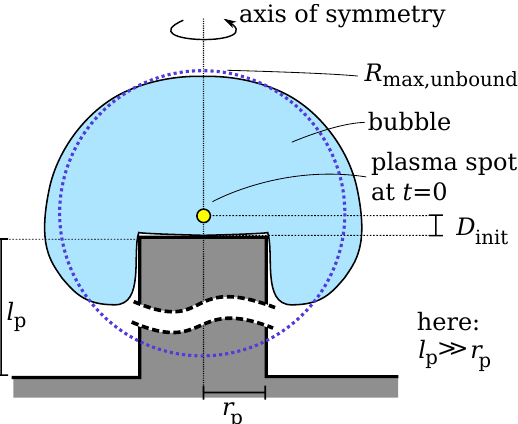
Figure 1. Sketch of the parameters for classification of bubbles close to a solid cylinder. The bubble is initiated by a hot plasma spot generated by a focused laser pulse. The radius R max,unbound is understood as the maximum radius of a spherical bubble with the same initial energy in an unbounded liquid. The radius of the spherical bubble with the same volume the bubble attains at maximum volume with the cylinder present (blue area) is the equivalent maximum radius R max,eq . Note that R max,unbound and R max,eq generally have different